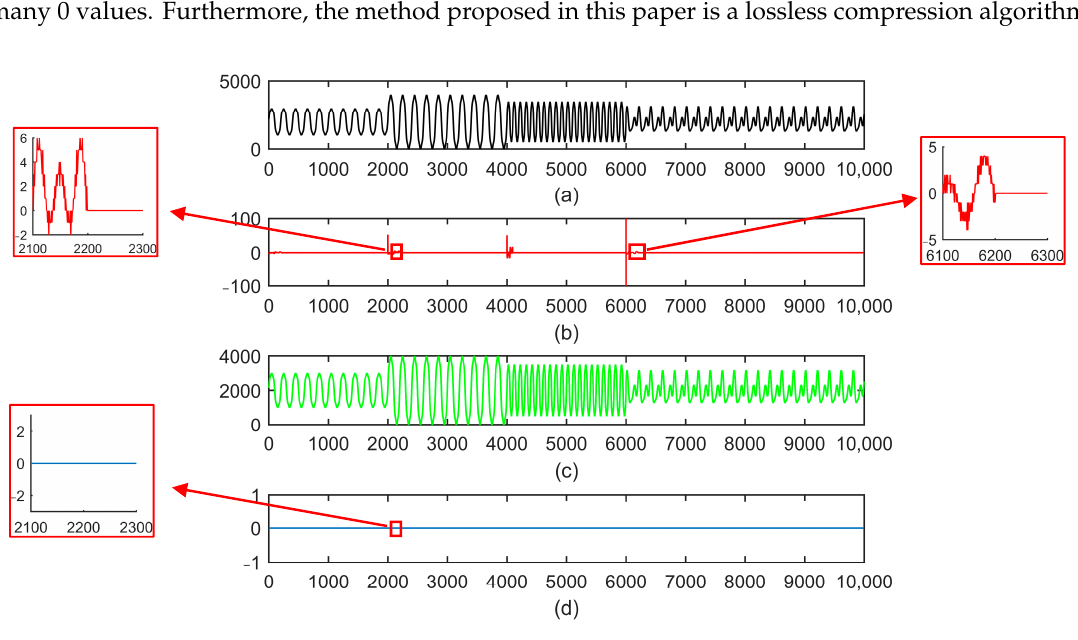
Figure 9. ( a ) The signals containing additive noise ( b ) Coding output ( c ) Decoding output ( d ) Error between the decoding output result and the original signal. Then, the period signal with period T = 200 is selected. The signal was cut to different sizes (L = 1, 2, …, 10 K), which were coded by the method proposed in this paper. The entropy of the coding output were calculated by Formula (8). By comparing the results in Figure 10, we can know that the larger the compressed data size, the better the predictive coding effect of this method. In addition, when the size of the compressed data